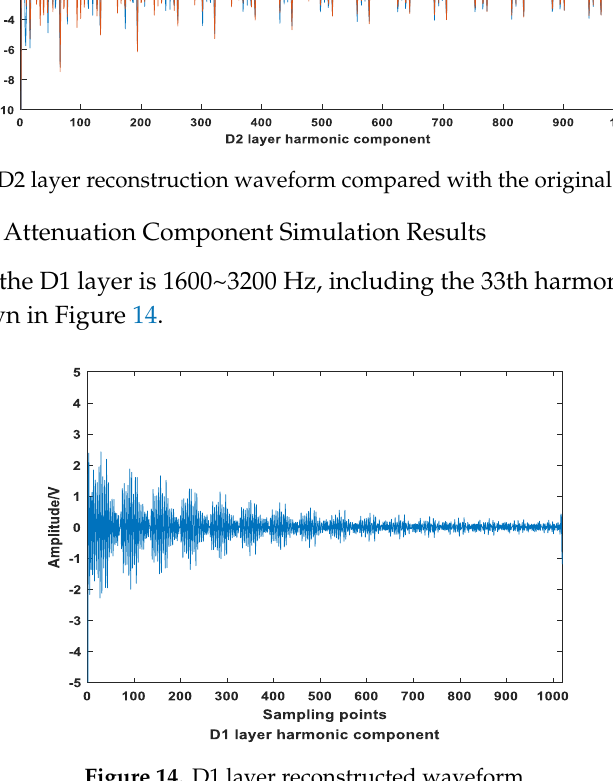
Figure-14. D1 layer reconstructed waveform.